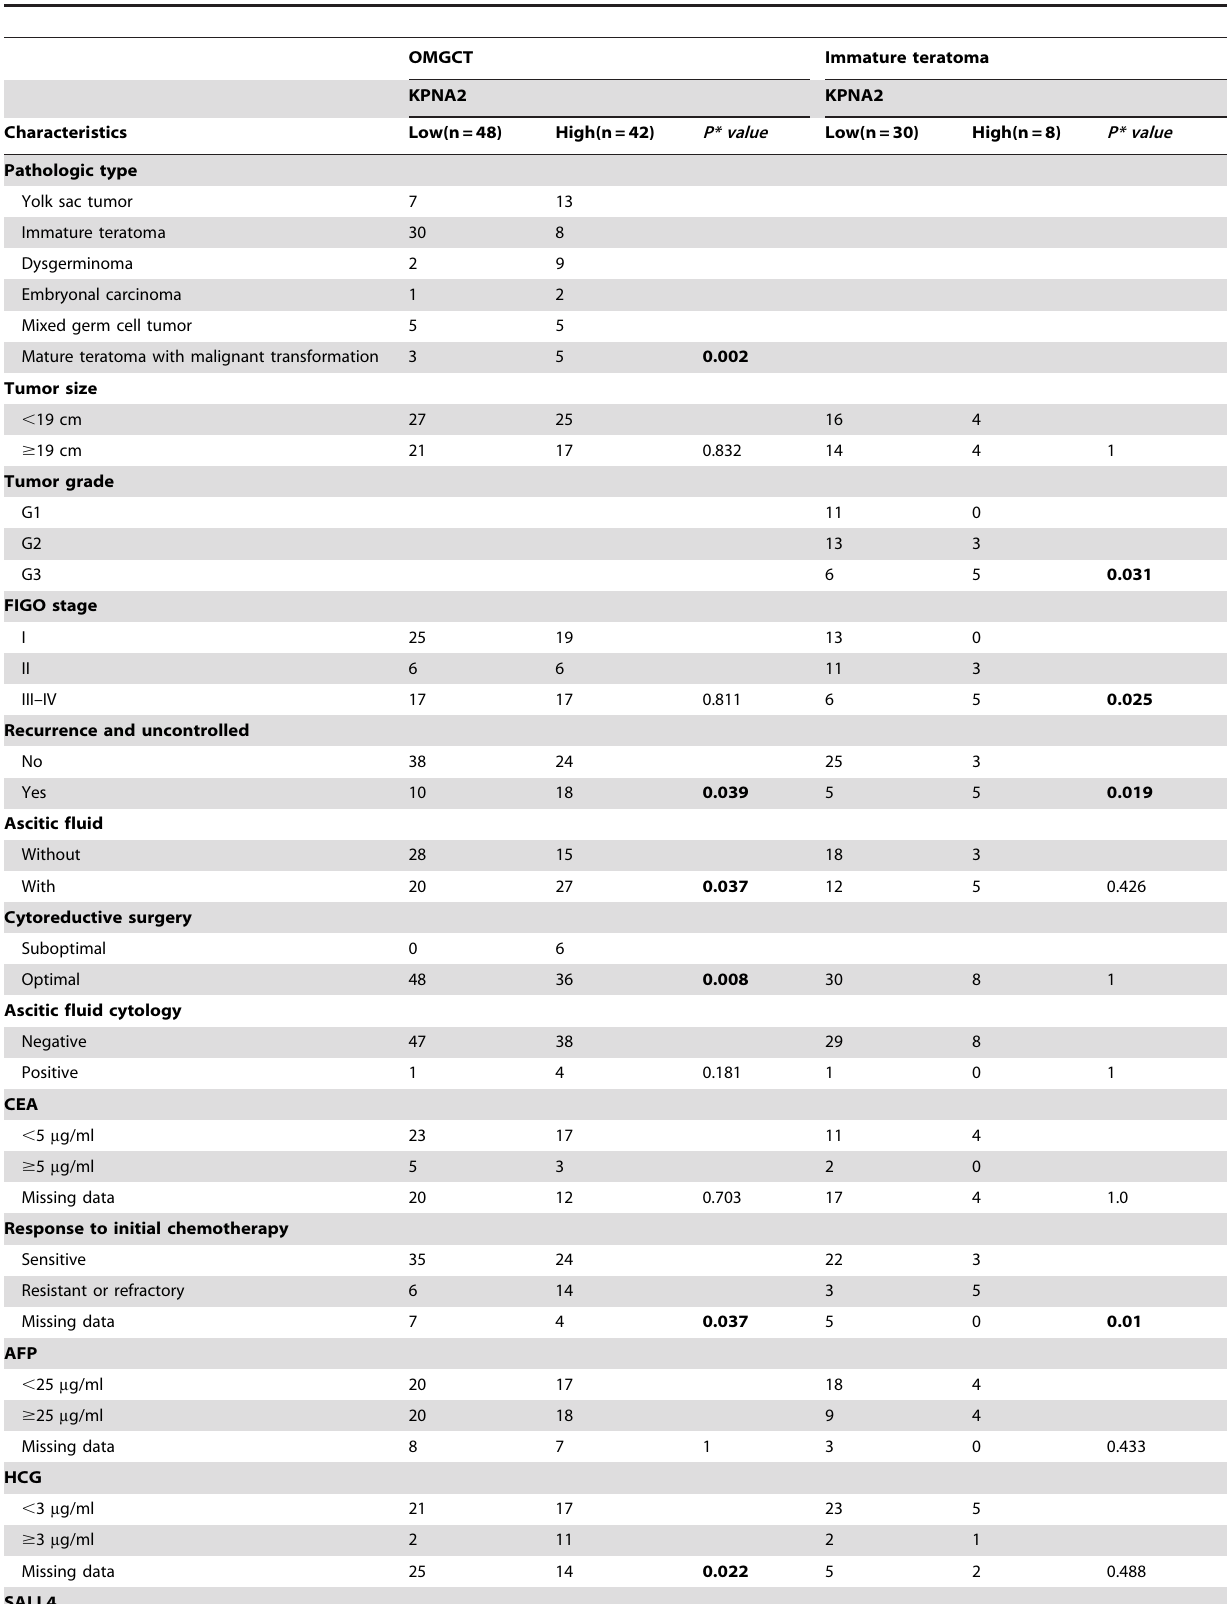
Table 3. Correlations between KPNA2 expression and clinicopathological features of patients with